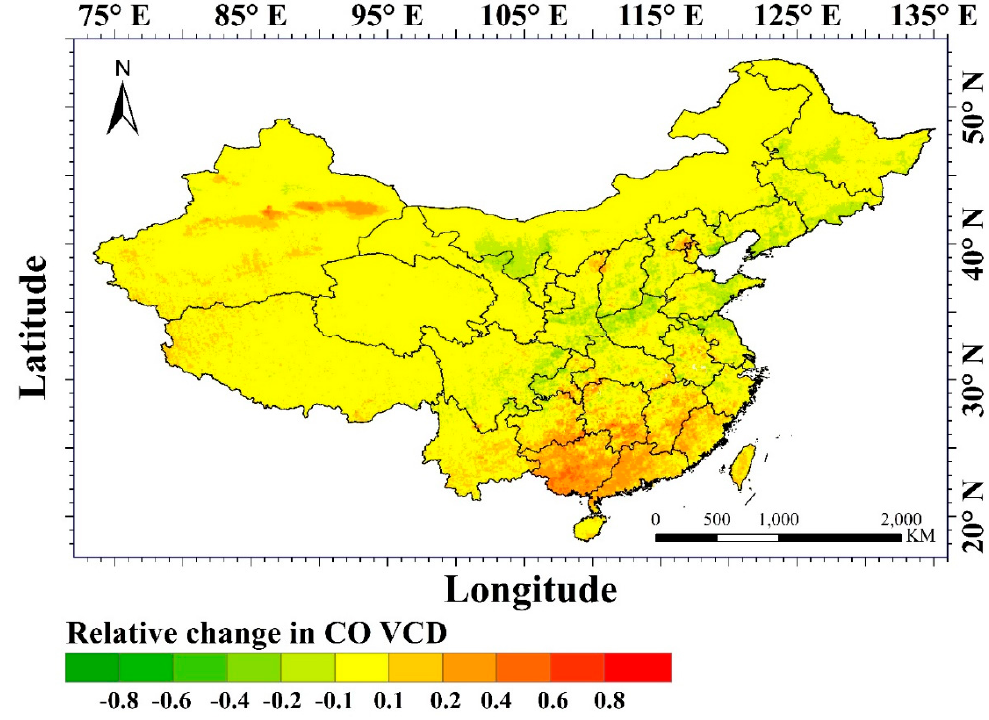
Figure 4. The same as Figure 3 but for CO.